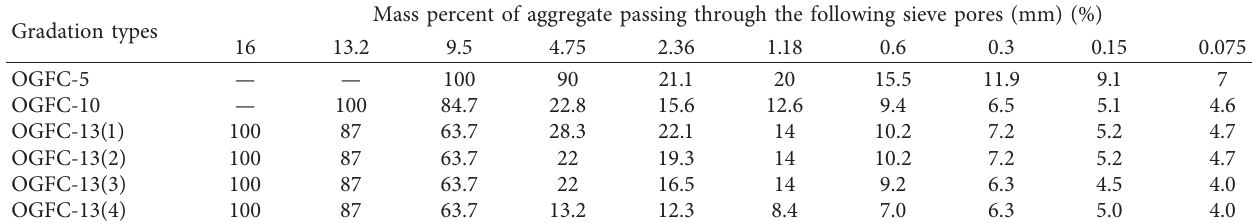
Table 4: Mixture gradation.